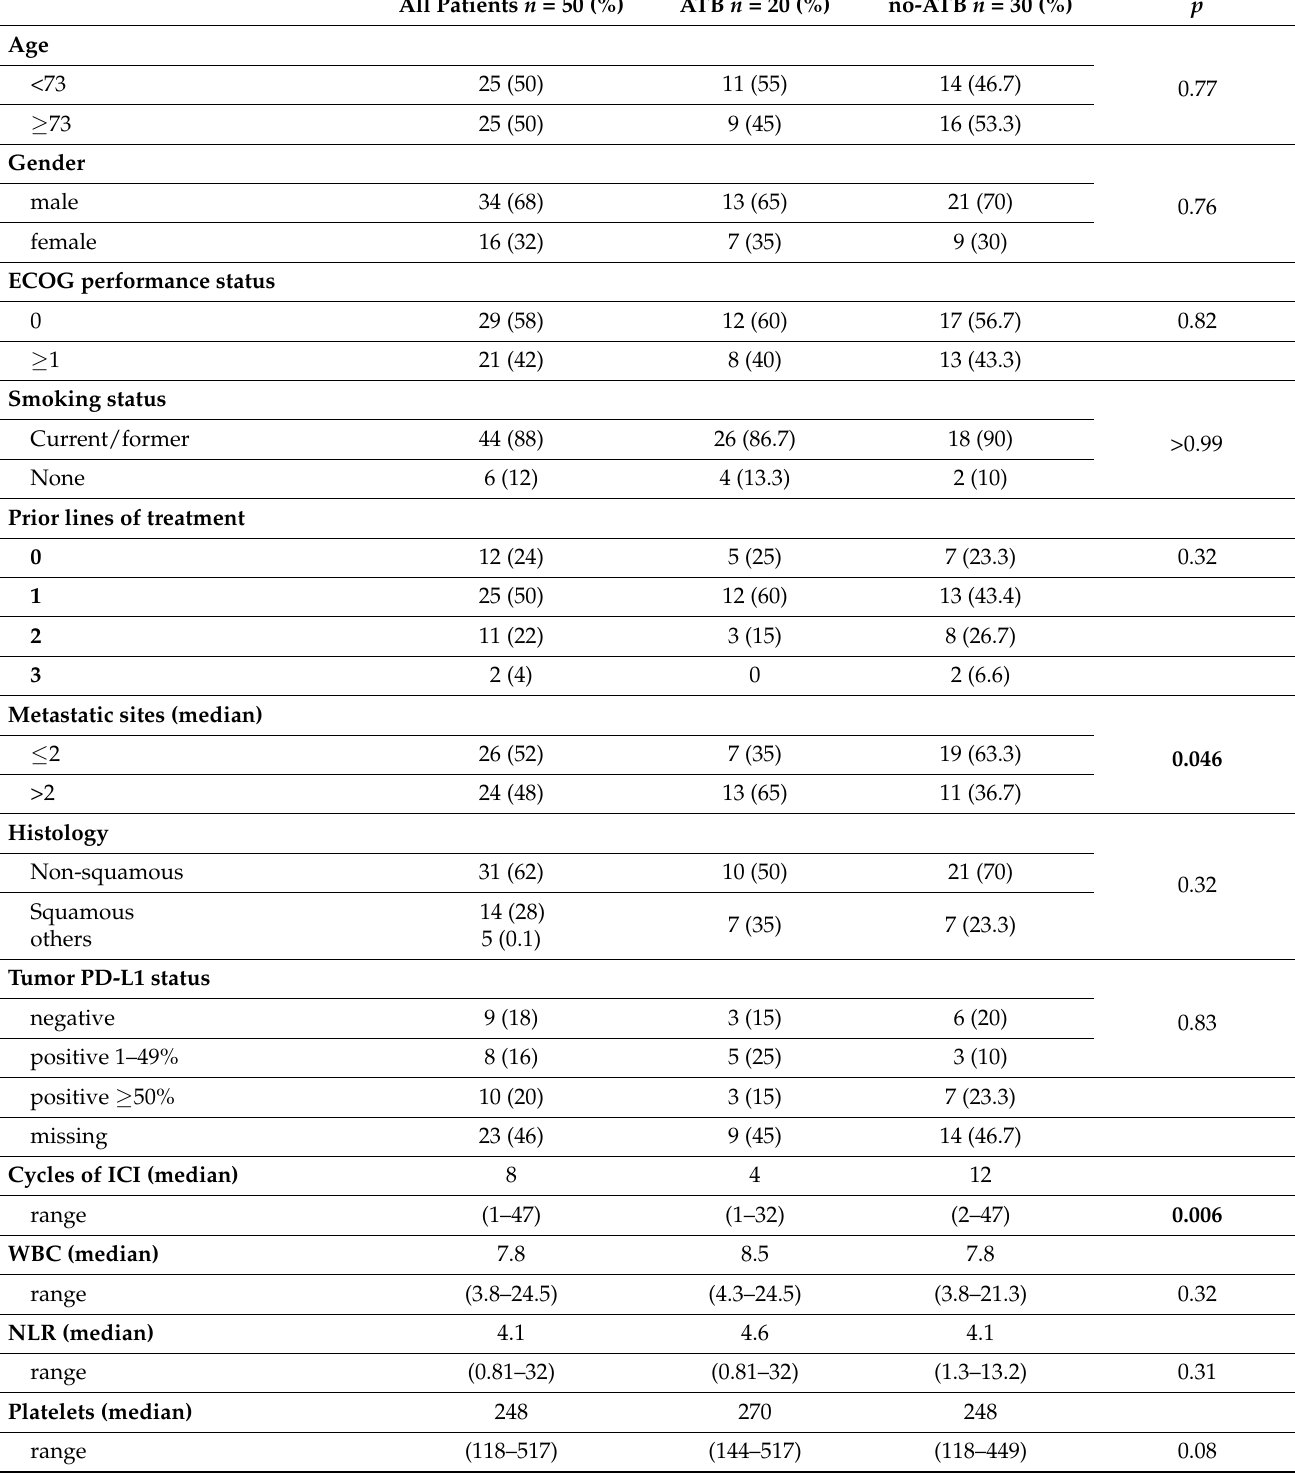
Table 1. Patient characteristics and association between ATB and clinical